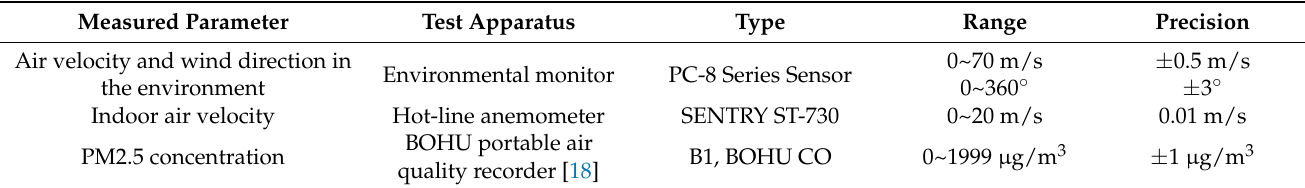
Table 1. Test apparatus and parameters.